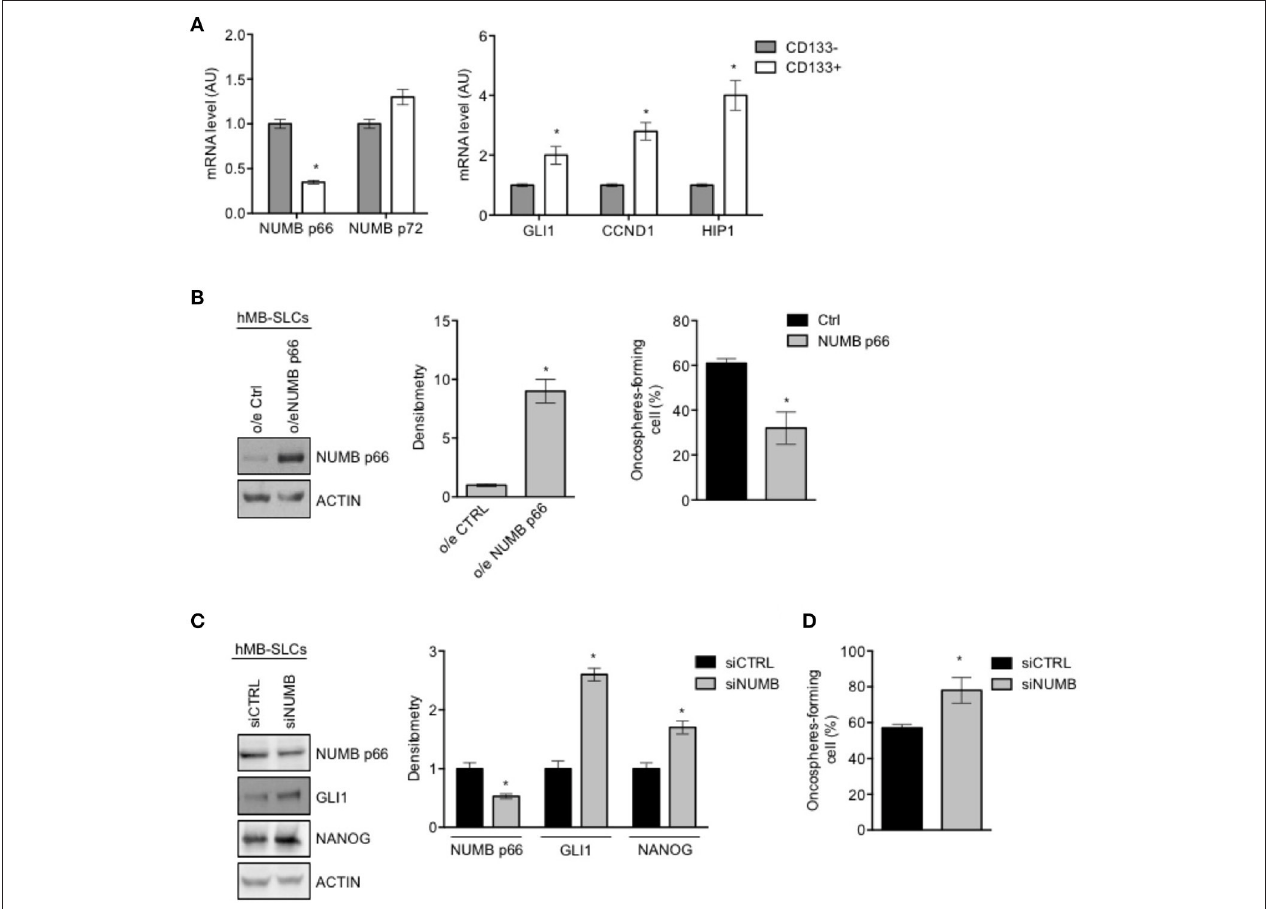
FIGURE 3 | Modulation of NUMB in hMB-SLCs. (A) qRT-PCR analysis showed mRNA expression of NUMB isoforms, p66, and p72, and of Hedgehog markers (GLI1, CCND1, HIP1) evaluated in hMB-SLCs CD133 + vs. CD133 − . Data represent means ± SD from 3 independent experiments. P -values * p < 0.05. (B) Representative western blot images (left) and densitometric analysis (center) of p66 in hMB-SLCs, after overexpression of p66 vs. Ctrl. ACTIN was used as loading control. (Right) Oncospheres-formation capacity of LvNumb-transduced hMB-SLCs vs. LvCtrl. P -values * p < 0.05. (C) Representative images of western blot (left) and densitometric analysis (right) analysis of p66, NANOG, and GLI1, in hMB-SLCs transfected with siRNA against NUMB (siNUMB) or non-targeting siRNA controls (siCTRL). ACTIN was used as loading control. P -values * p < 0.05. (D) Oncospheres-formation capacity of siNUMB hMB-SLCs vs. siCTRL. P -values vs. siCTRL. Data represent means ± SD from three independent experiments. P -values * p < 0.05. (B–C) Data are means ± SD from three independent experiments. Full-length images are presented in Supplementary Figures